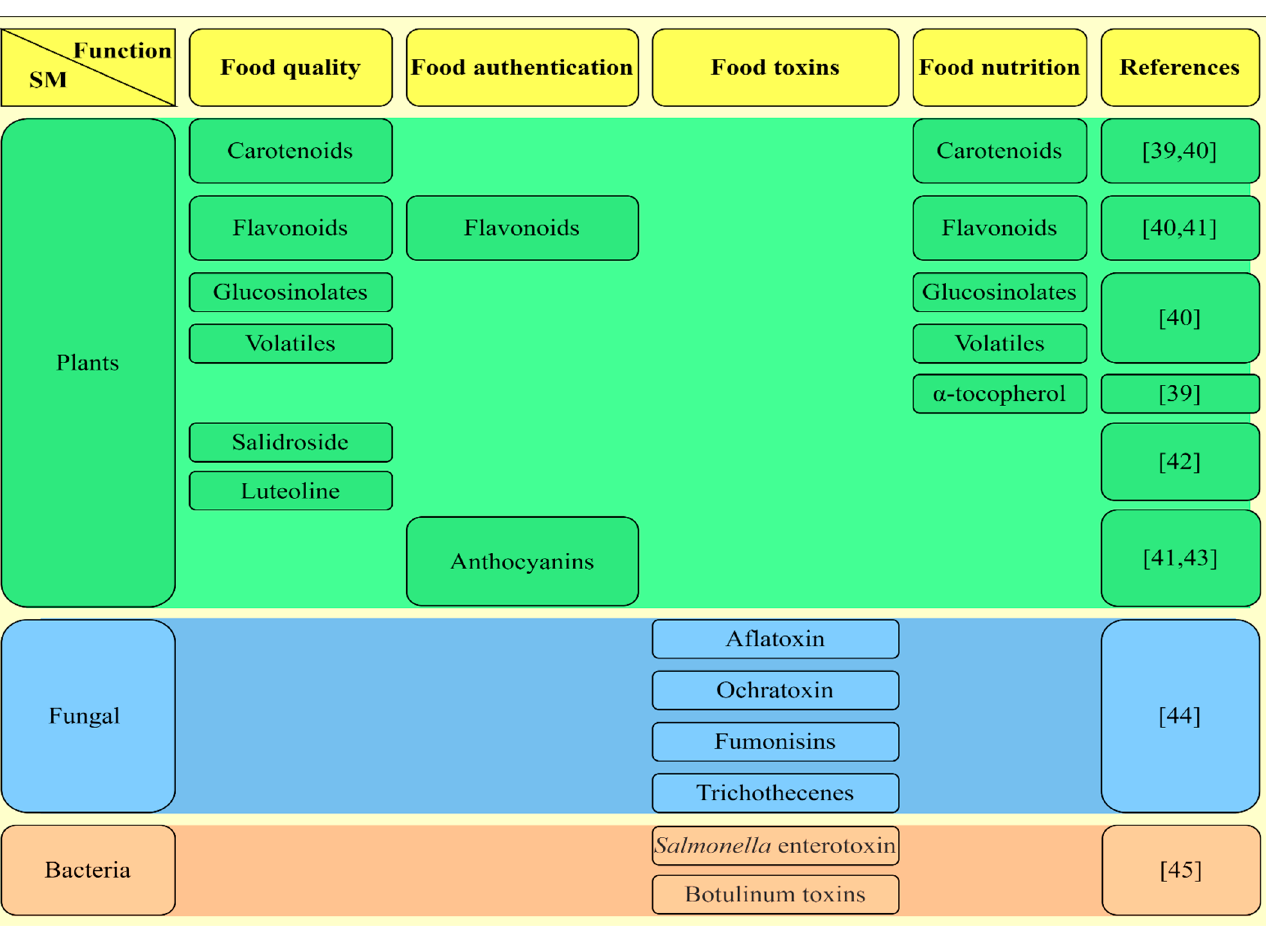
Figure 1 . Depiction of some examples of applications of secondary metabolites from bacteria, fungi, and plants in metabolomics, mainly as biomarkers, found in previous studies. The same metabolite may have different functions in the food field, for example, as an indicator of quality in the processing and as a nutritional component. In addition, the metabolites of microorganisms are mostly indicative of toxins and food contamination [39–45] .